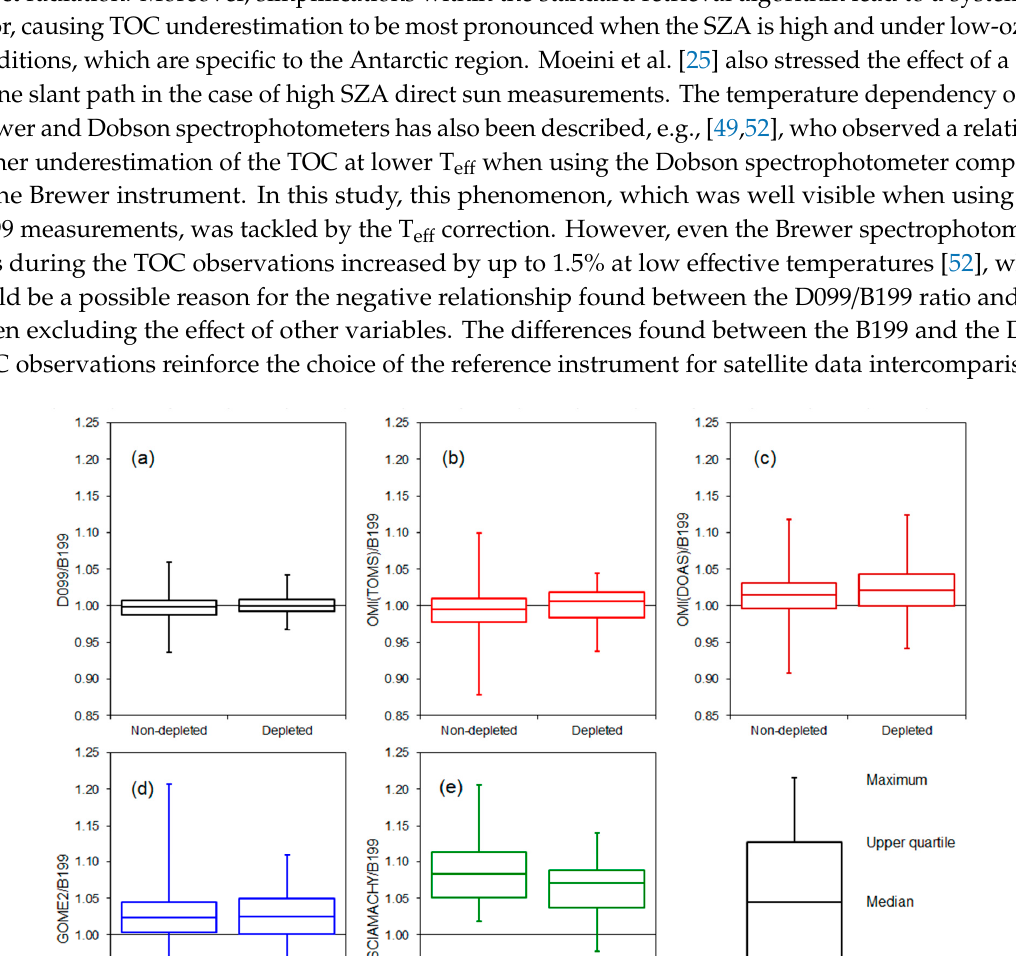
Figure 6. Basic statistical characteristic of the ratios in relation to the B199 ozone column for ( a ) the D099, ( b ) the OMI(TOMS), ( c ) the OMI(DOAS), ( d ) the GOME2, and ( e ) the SCIAMACHY under